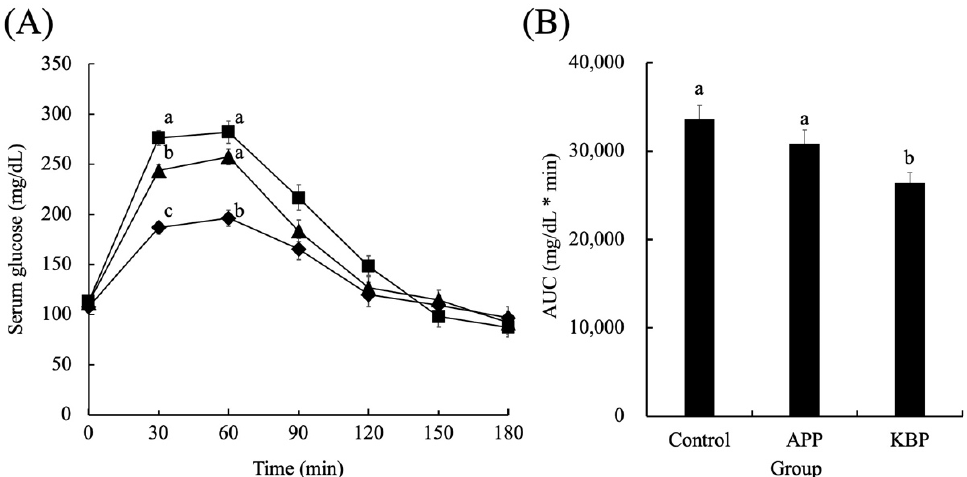
Figure 2. Serum glucose concentrations as a function of time ( A ) and area under the curve ( B ) during MTT. Control ( ■ ), APP ( ▲ ), and KBP ( ◆ ) groups. Data represent mean ± standard error from the data of 8 animals per group. Means were compared using analysis of variance, followed by Tukey’s multiple comparison test with a cut-off level of 0.05 probability of significance. Different letters of the same item indicate significant differences. APP, Alaska pollock protein; AUC, area under the curve; KBP, kamaboko protein; MTT, meal tolerance test.